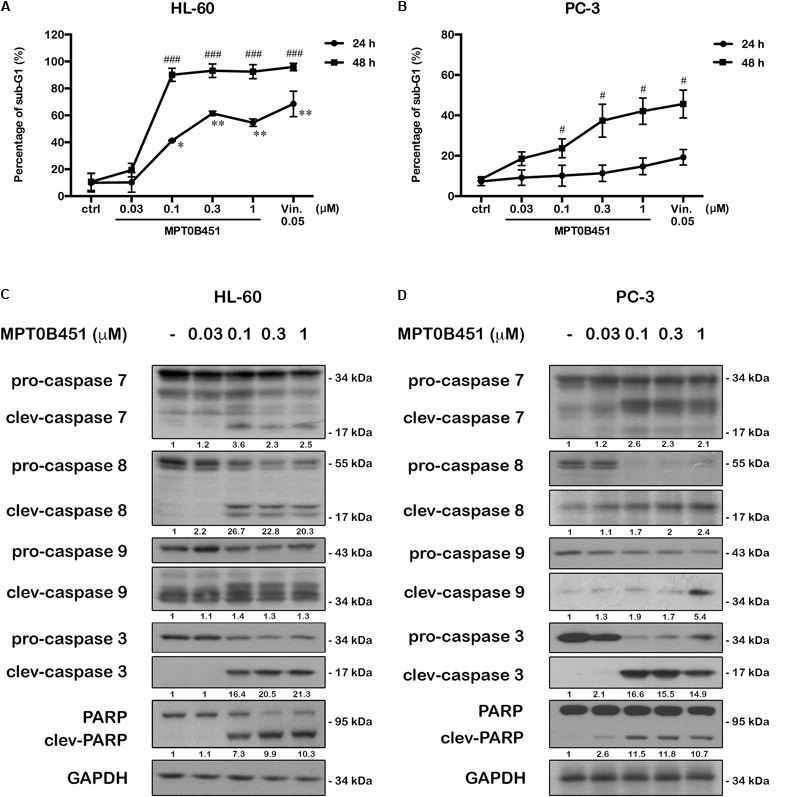
MPT0B451 induces cell apoptosis and activates apoptotic protein expression in HL-60 and PC-3 cells. The sub-G1 profiles of HL-60 (A) and PC-3 (B) cells were treated with indicated concentrations of MPT0B451 or vincristine (vin., 0.05 μM) for 24 or 48 h, and detected by flow cytometry. The results represent the mean ± SD of three independent experiments at ∗p < 0.05 and ∗∗p < 0.01 compared with 24 h control group; #p < 0.05 and ###p < 0.001 compared with 48 h control group. (C,D) Apoptotic proteins were activated after MPT0B451 treatment for 24 h (HL-60) or 48 h (PC-3). The whole cell lysates were subjected to western blotting, and the data were repeated at least three independent experiments.